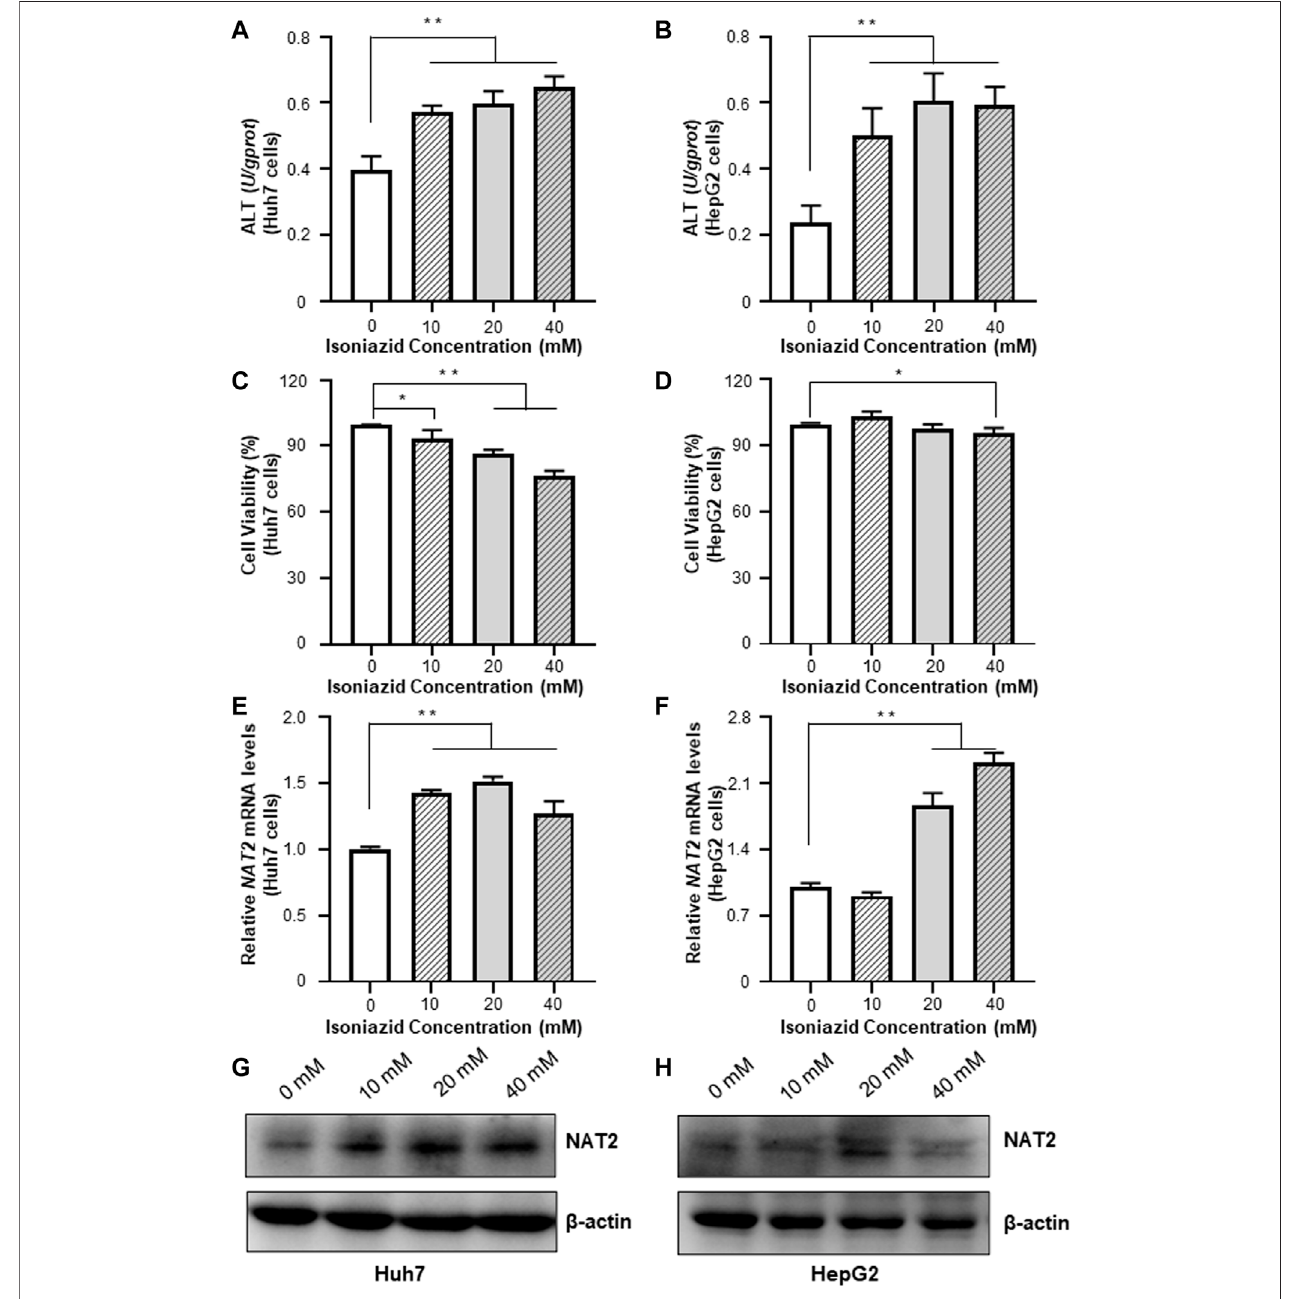
FIGURE 3 | Effects of INH on the ALT enzyme activities and NAT2 expression of Huh7 and HepG2 cells. (A,B) Changes of ALT enzyme activities in Huh7 and HepG2cellstreatedwithINH. (C,D) ChangesofcellviabilityinHuh7andHepG2cellstreatedwithINH. (E,F) ExposuretoINHatdifferentworkingconcentrationscaused the expression of NAT2 mRNAlevelsin Huh7 and HepG2 cells. (G,H) Exposure toINH at different workingconcentrations caused theexpression of NAT2 protein levels in Huh7 and HepG2 cells. Data represented three independent experiments and were shown as mean ± SD. * p < 0.05; ** p <